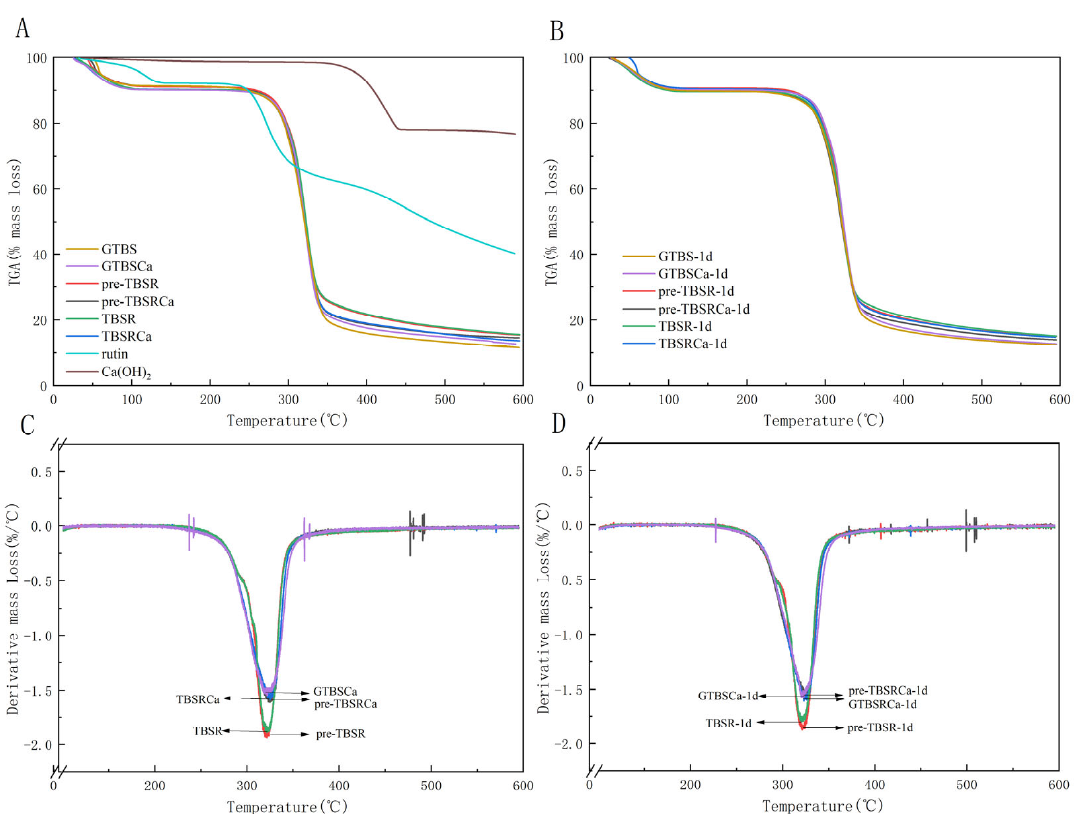
Figure 3. TGA curves of gelatinized ( A ) and retrograded ( B ) samples; DTG curves of gelatinized ( C ) and retrograded ( D ) samples.